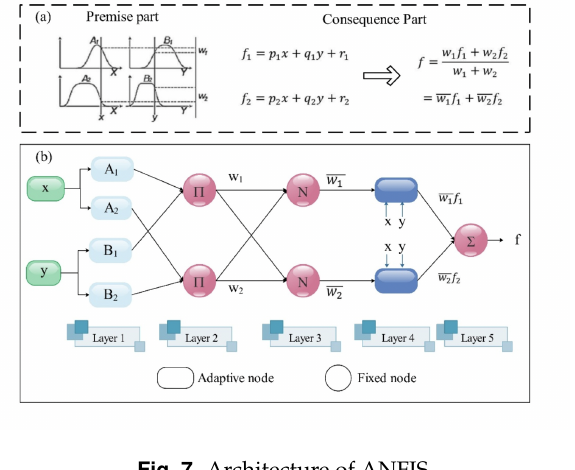
Fig. 7. Architecture of ANFIS